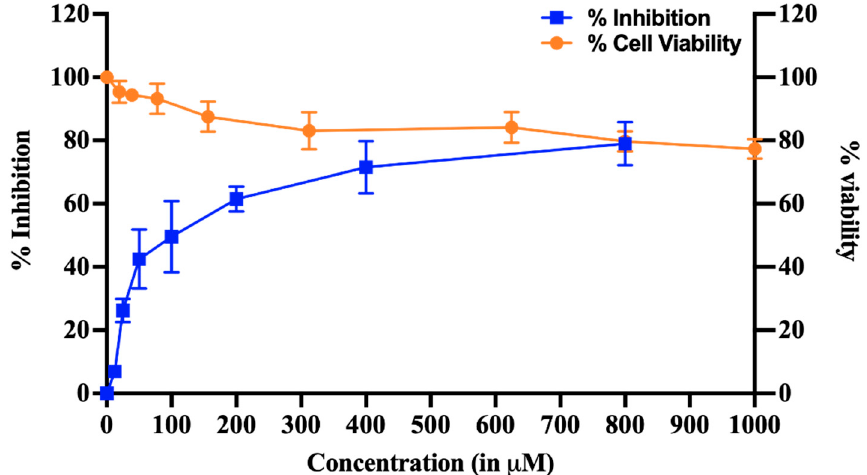
Figure 8. Cell Viability and inhibition of HEV Replicon. The dose-dependent curve represents % inhibition of viral replication in HEV replicon-based assay and cytotoxicity profile of HPPA. The dose-dependent graph was generated by quantifying luminescence, and cytotoxicity was examined using an MTT assay. The blue line in the graph represents the % inhibition, and the orange line represents the cell viability in the presence of HPPA. The calculated CC 50 and IC 50 of the compound were found to be more than 1 mM and 77.12 ± 18.7 μ M, respectively.